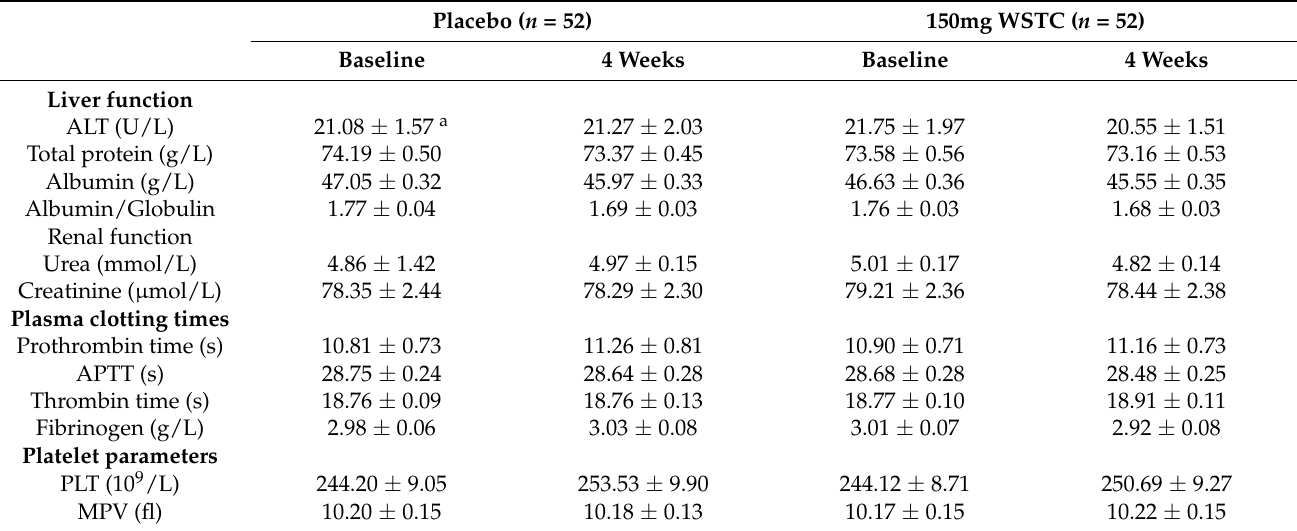
Table 2. Blood chemistry and plasma clotting times at baseline and after the 4-week treatment b